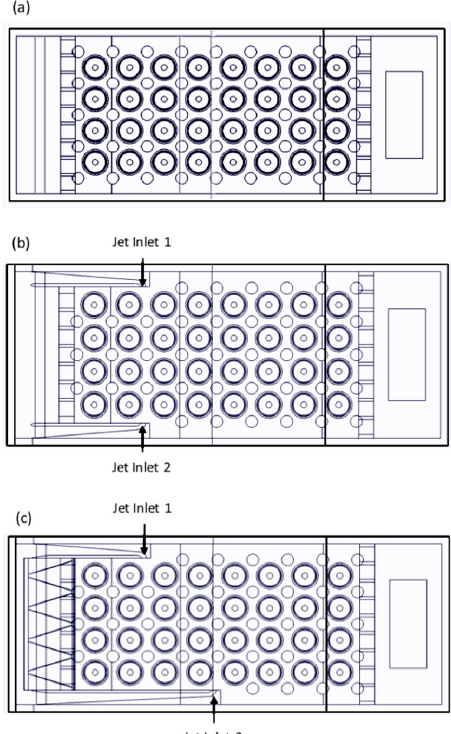
Figure 2. Top view of schematics of ( a ) Case 1; ( b ) Case 2; and ( c ) Case 4.